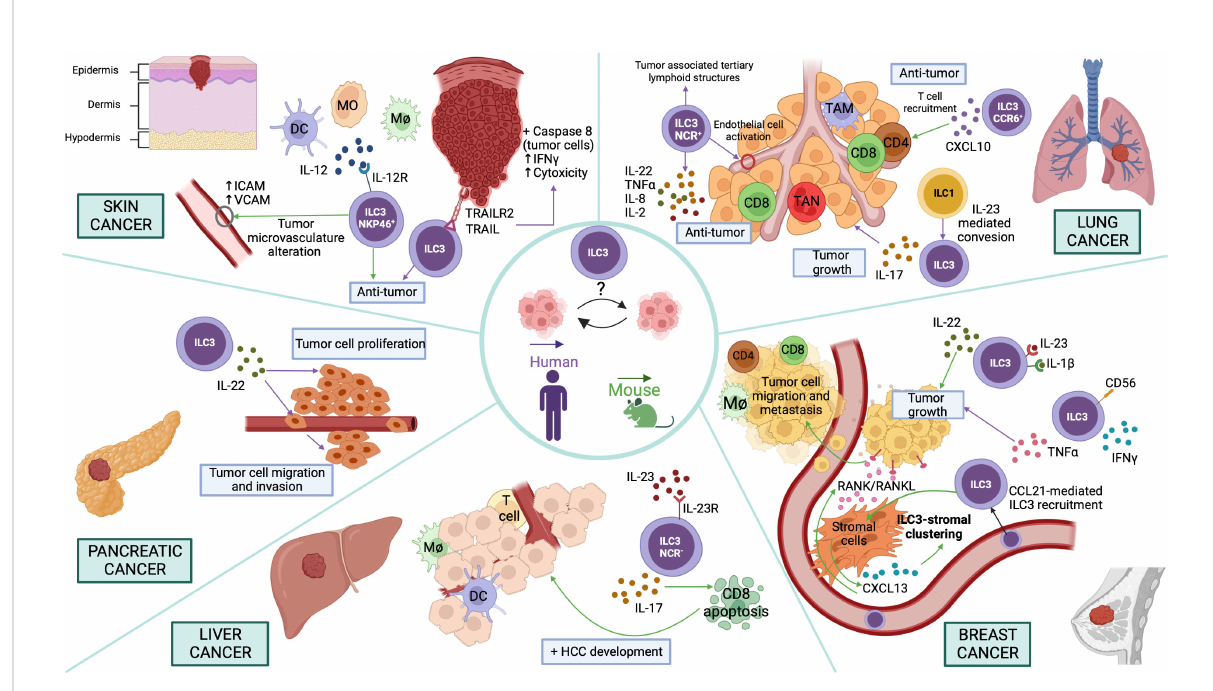
FIGURE 2 Potential functions of ILC3s in different cancer types Skin cancer. NKp46 + ILC3s play an anti-tumor role in presence of IL-12 upregulating adhesion molecules in the vessels. ILC3s exert an anti-tumor effect through the recognition of tumor cells by TRAIL/TRAILR2, which